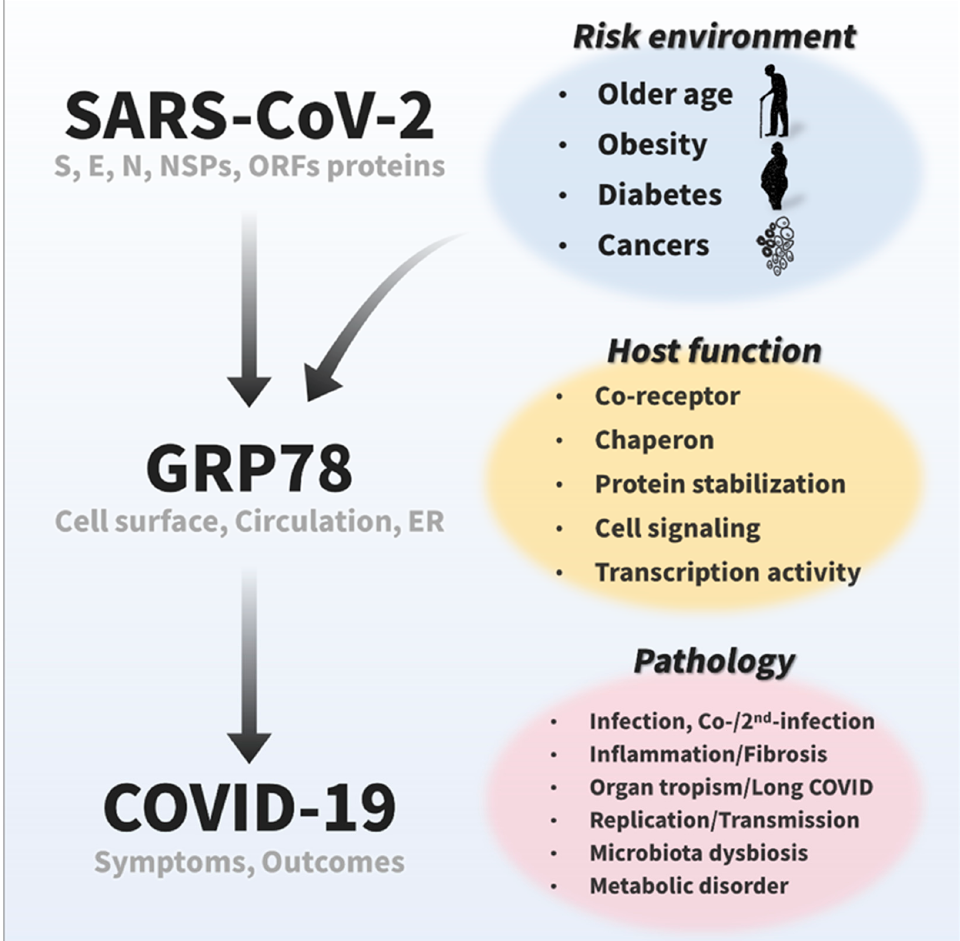
Figure 5 . Emerging and potential roles of GRP78 in COVID-19. Recent studies have suggested that GRP78 on the cell surface and in circulation acts as a host co-receptor for SARS-CoV-2 infection [12,15], and cumulative protein interactome data have shown that GRP78 also could interact with other viral proteins of SARS-CoV-2 [16]. The expression of GRP78 is highly relevant to COVID-19 risk factors, such as older age, obesity, diabetes, and cancer [12,21–23,61]. Given its significant roles in a wide range of biological processes, including protein homeostasis and cellular signaling, GRP78 cation, translation, assembly, egress/exocytosis, stabilization, etc.) and pathology (inflammation,